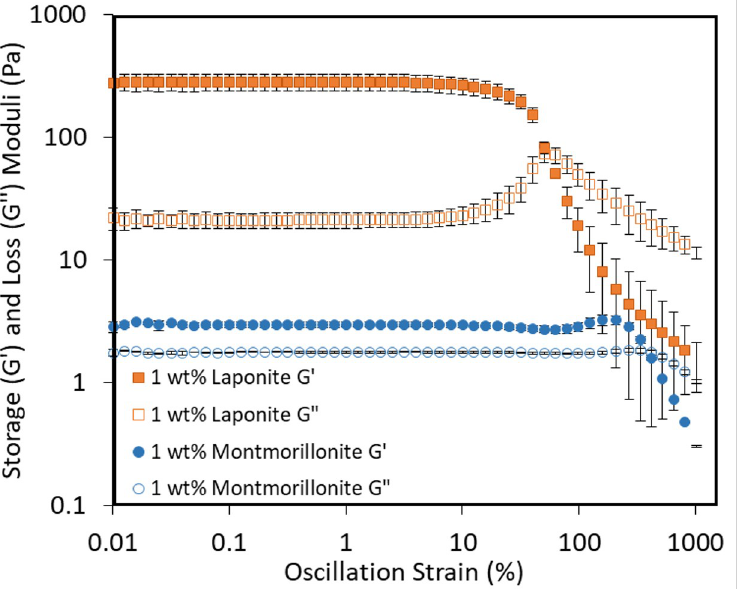
Fig 4. Amplitude sweep curves of 1 wt% Laponite (orange squares) and 1 wt% montmorillonite (blue circles) in 1.5 wt% OCNF. Storage moduli (G’) shown with filled symbols, loss moduli (G") shown in open